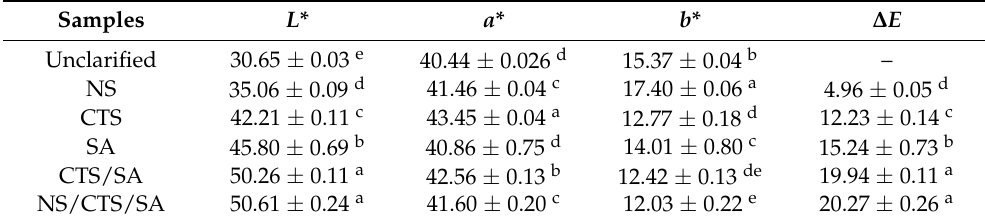
Table 4. Effects of different clarification methods on color parameters of bayberry